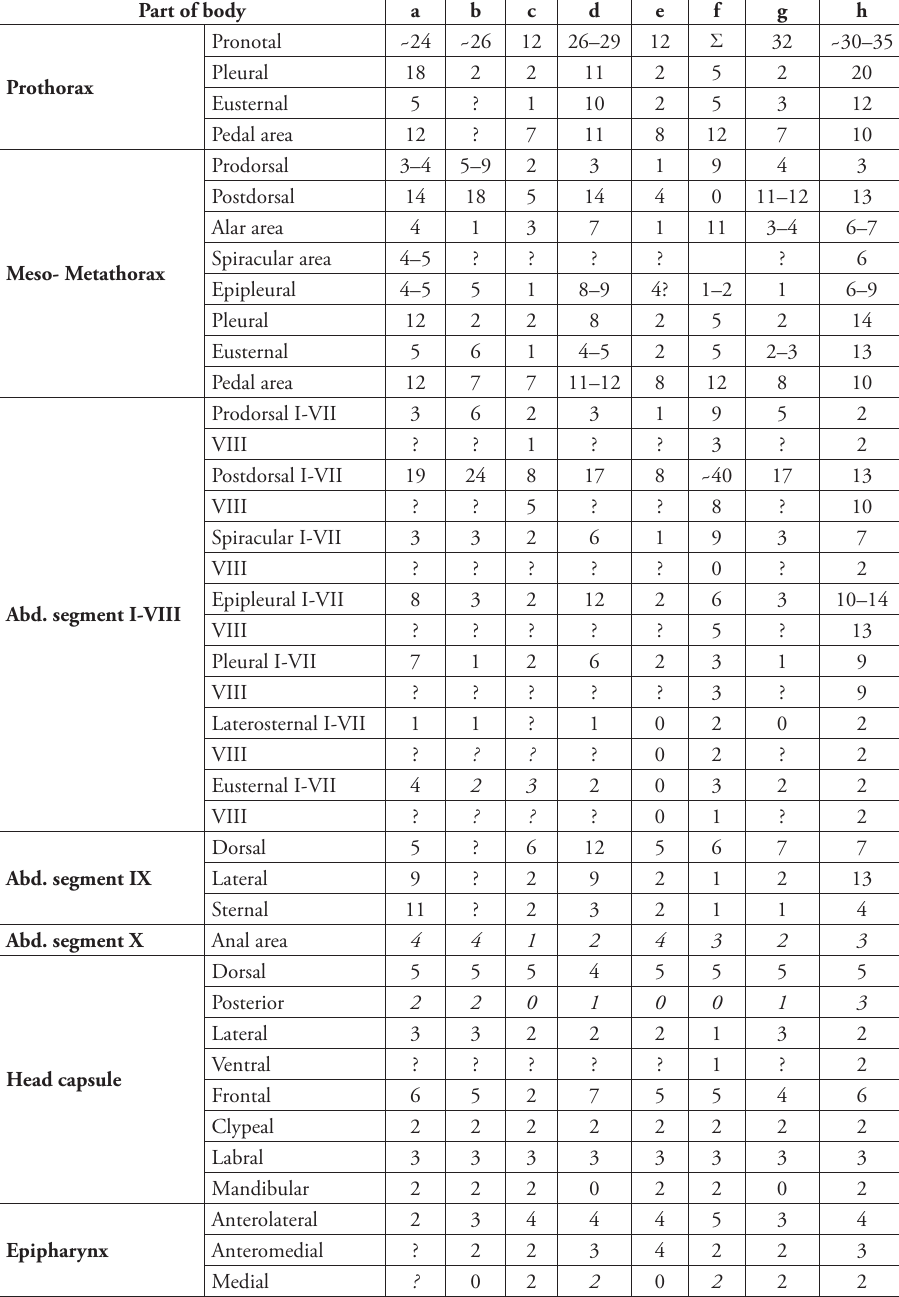
Table 1. Larval setal index of species from the subgenus Larinus : (a) L. capsulatus , (b) L. fucatus , (c) L. idoneus , (d) L. inaequalicollis , (e) L. latus , (f) L. pollinis , (g) L. sibiricus and (h) L. vulpes (italics – micro- setae; Σ – uncountable, defined as more than 50; ? – no data). Part of body Prothorax